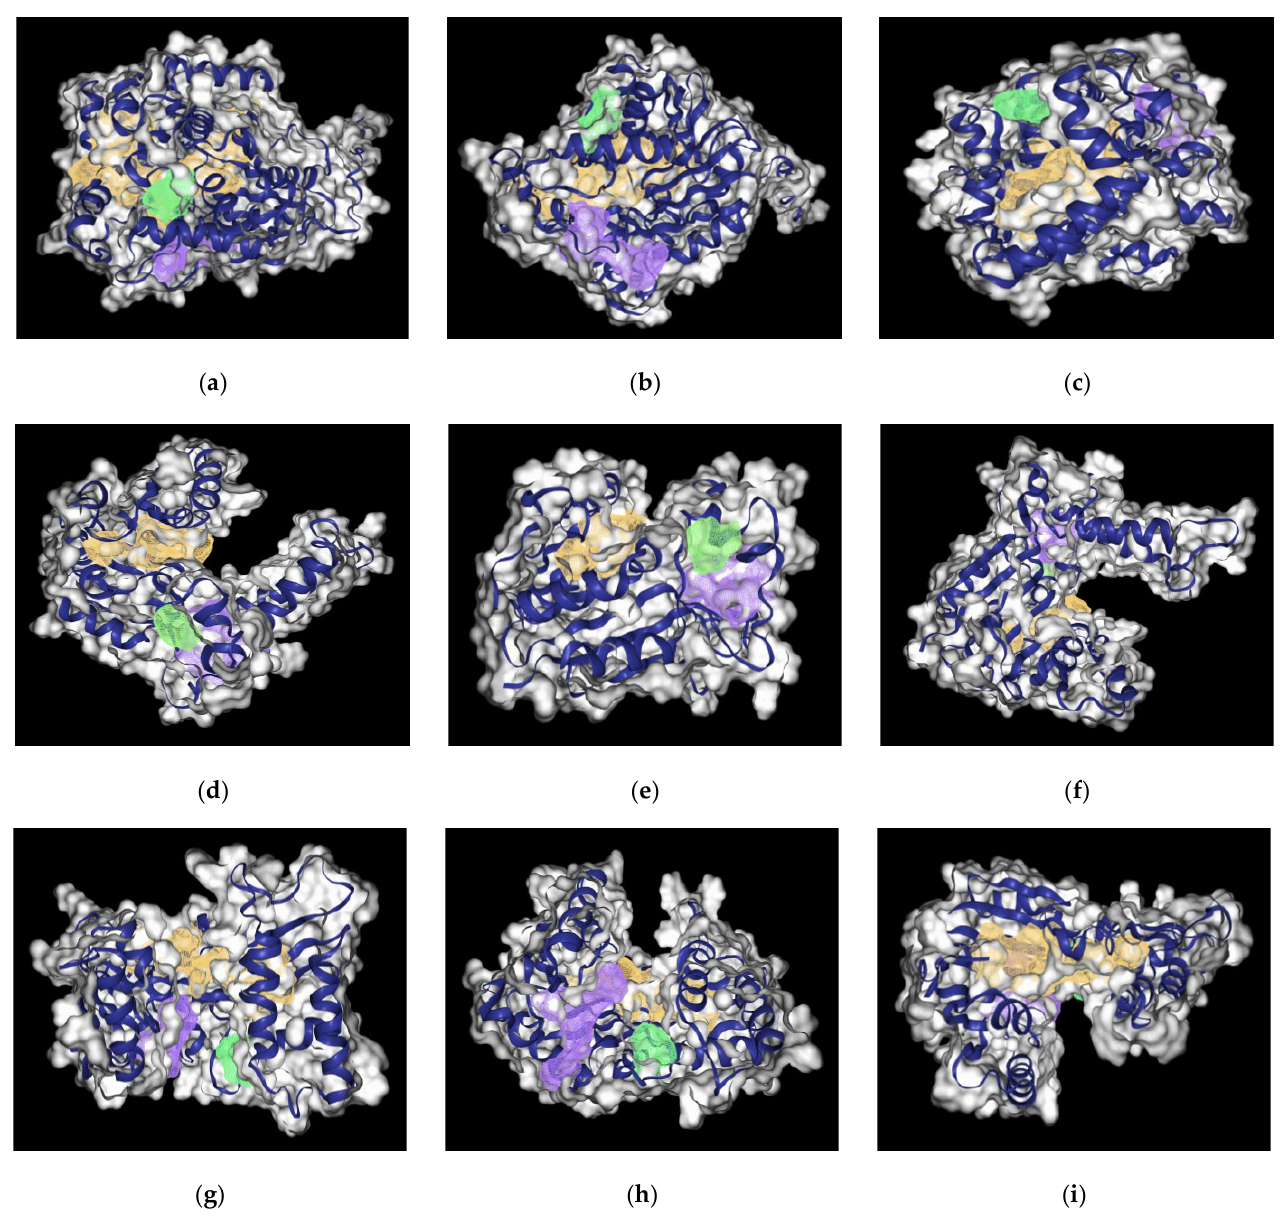
Figure 4. Binding pocket analysis for modelled proteins . Images ( a – c ) depict the top drug binding pockets within the yeast derived protein ERG6 structure at three different angles rotated at 90° to each other. ( d – f ) show N. gruberi derived protein XP and ( g – i ) protein XM structure at three different angles rotated at 90° to each other. The image shows color with decreasing order of druggability score, with the color coded as orange, purple and green, respectively.